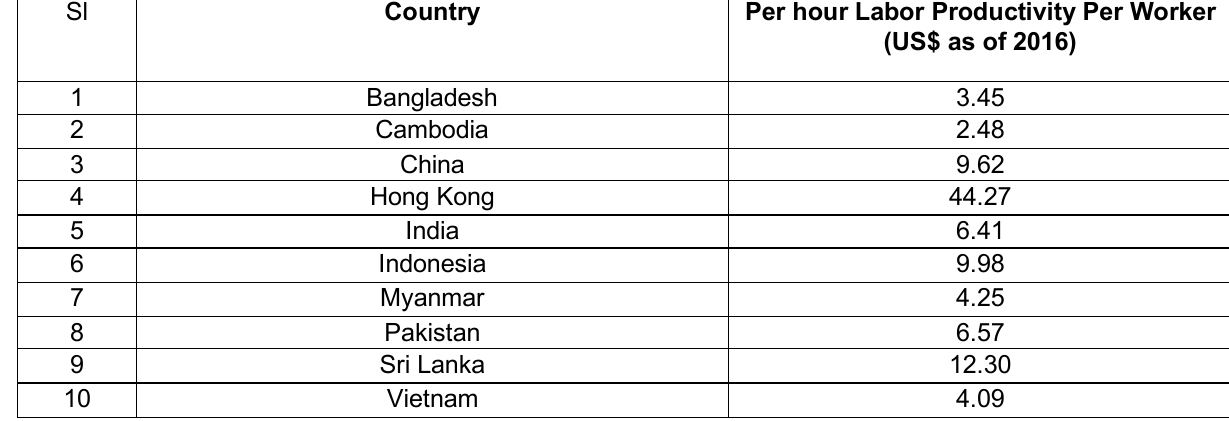
Table 3: Per Hour Labor Productivity Per Worker in Bangladesh And Competing Countries